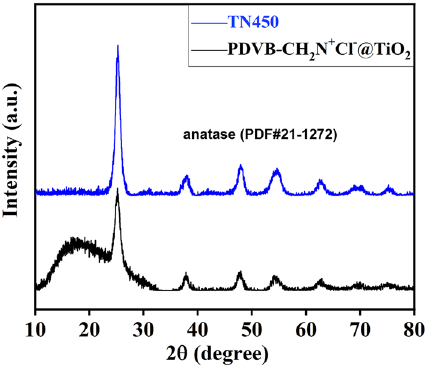
Figure 4. The XRD spectrum of PDVB-CH 2 N + Cl − @TiO 2 and TN450.